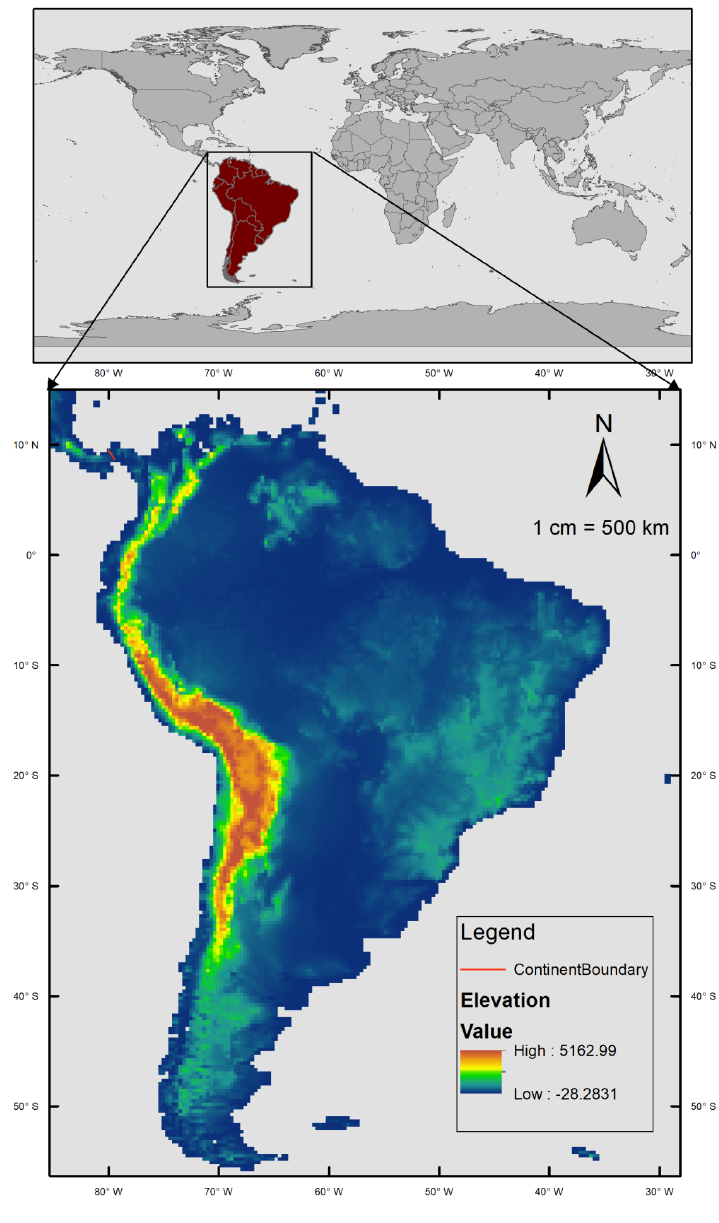
1 Figure 1. Geographical location and elevation map of the study